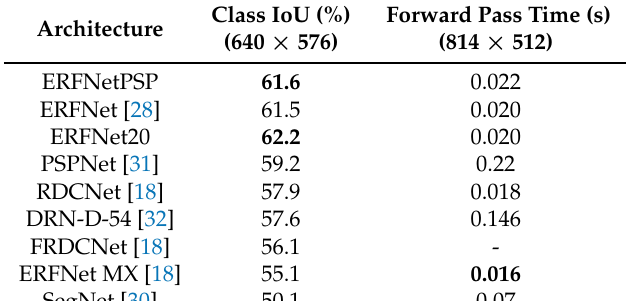
Table 3. Performance-efficiency comparison for the presented architectures.